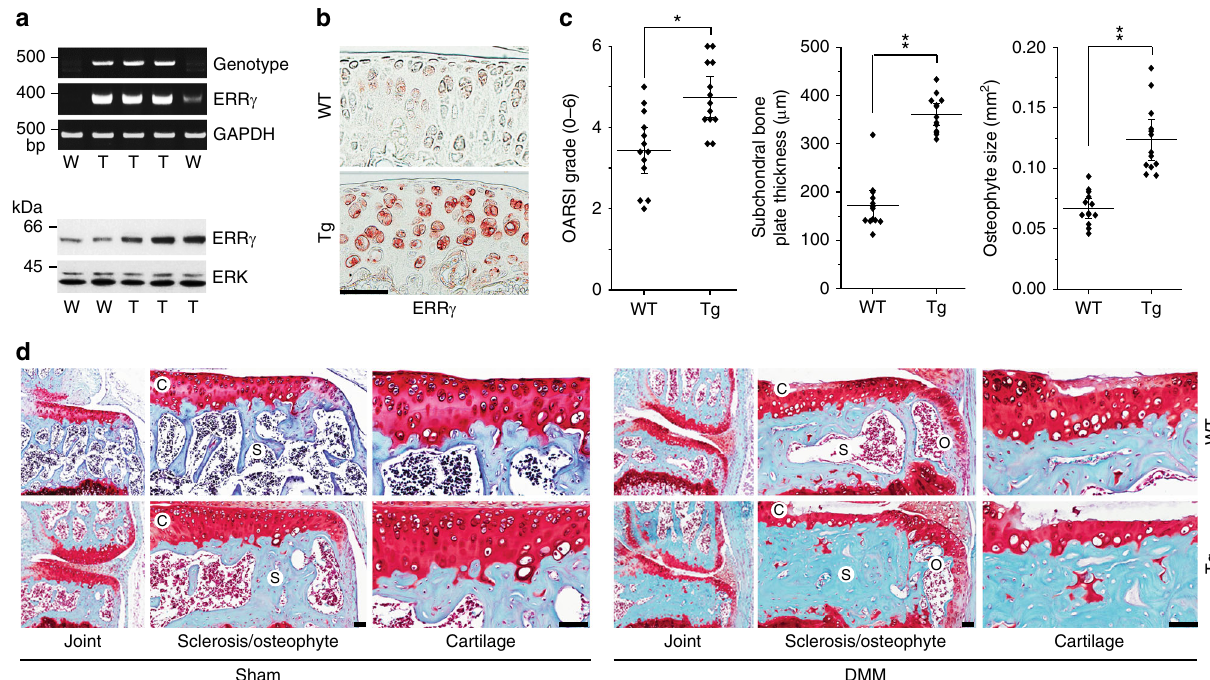
Fig. 4 Col2a1-Esrrg Tg mice exhibit enhanced experimental OA. a Genotypes and ERR γ mRNA and protein levels were determined from primary cultured chondrocytes isolated from Col2a1-Esrrg Tg mice and WT littermates. GAPDH and extracellular signal-regulated kinase (ERK) were used as loading controls. b Immunostaining for ERR γ protein in cartilage of Col2a1-Esrrg Tg mice and WT littermates. c , d Col2a1-Esrrg Tg mice and WT littermates were subjected to sham operation or DMM surgery. OARSI grade, subchondral bone plate thickness, and osteophyte size were quanti fi ed in WT and Col2a1 - Esrrg TG mice ( n = 13 mice per group), mice 8 weeks after sham operation, or DMM surgery ( c ). Representative images of cartilage destruction, subchondral bone sclerosis, and osteophyte formation determined by safranin-O staining ( d ). Values are presented as means ± s.e.m. (* P < 0.001 and ** P < 0.0001). Two-tailed t test and Mann – Whitney U test. Scale bar: 50 μ